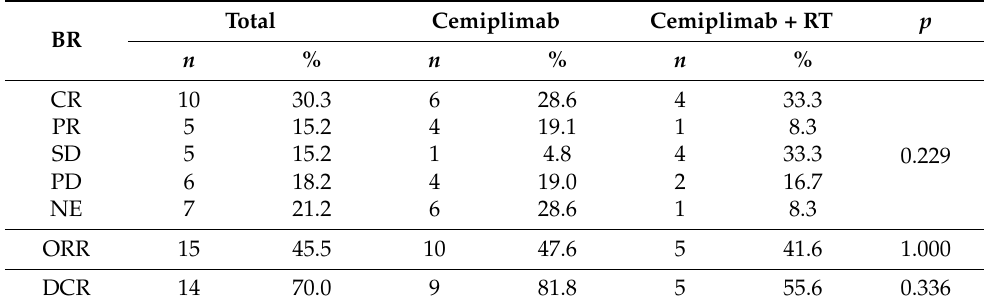
Table 2. Best overall responses and disease control